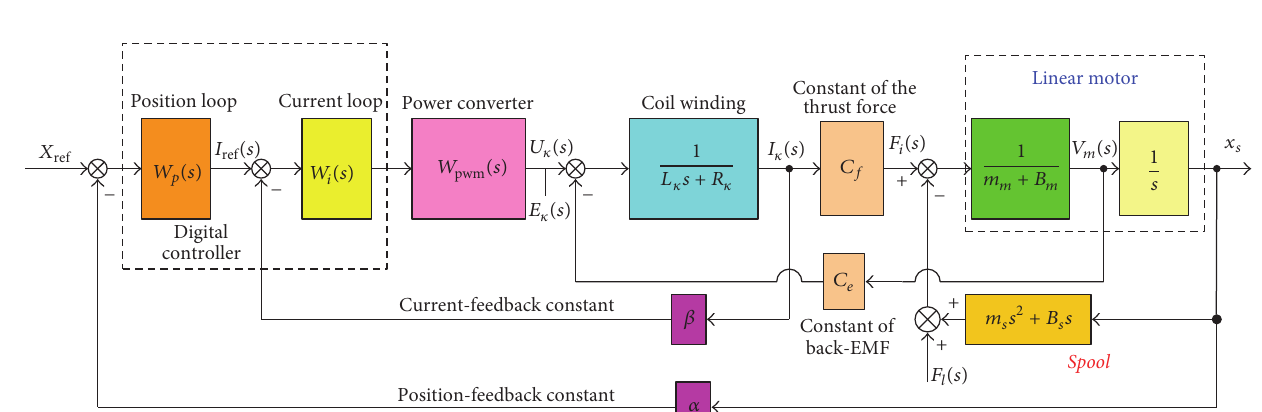
Figure 1: The structure of the DDA.